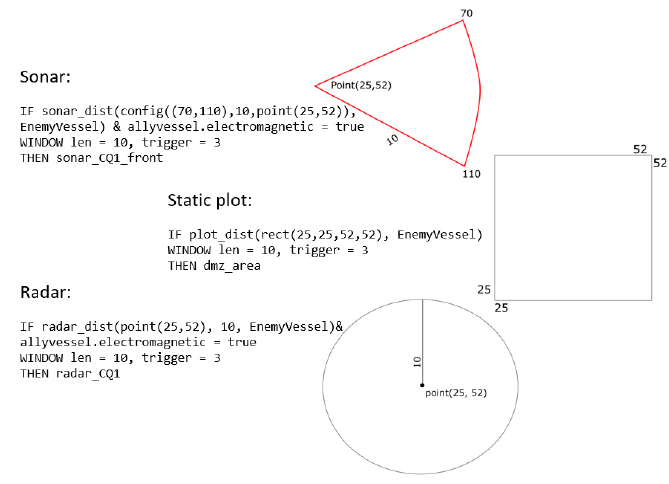
Figure 4. Rule examples with spatiotemporal CQ conditions.